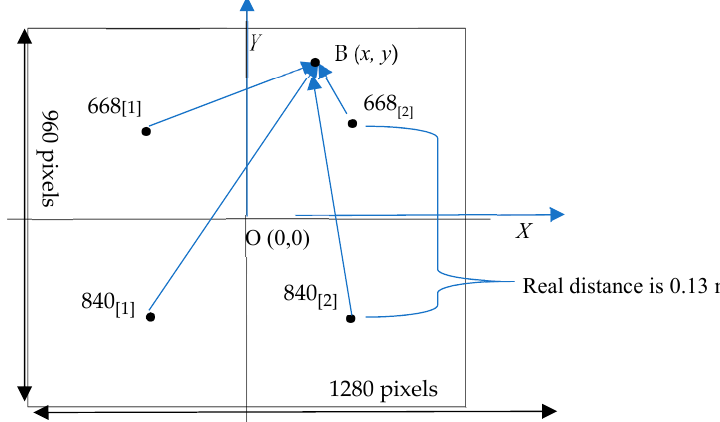
Figure 8. Distribution of the radiation intensity of incident light in multi-spectral images.